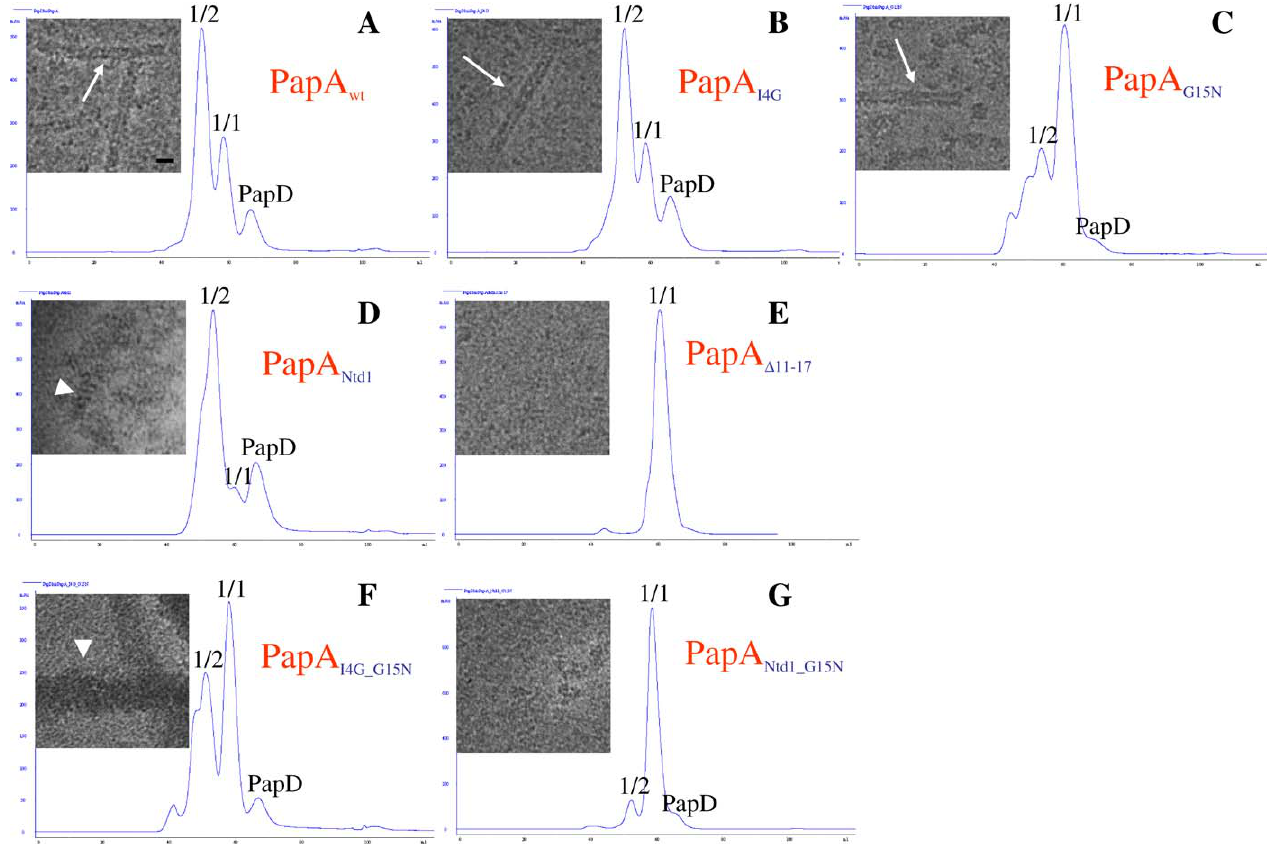
Figure 6. Gel Filtration Profiles and EM pictures of PapD/PapA Wild-Type (wt) and Mutant Complexes Each gel filtration profile of a particular PapA construct is shown with a view of its corresponding EM picture on the left. The complex is labeled on the right. Only the gel filtration peaks corresponding to free PapD, PapD/(PapA) 1 (1/1) or PapD/(PapA) 2 (1/2) are labeled. Representative pili are labeled with arrows ([A–C]). Non-pilus polymerization of protein is labeled with arrowheads ([D] and [F]). The scale of all the EM pictures is represented by the black bar on the PapD/PapA wt picture and corresponds to 100